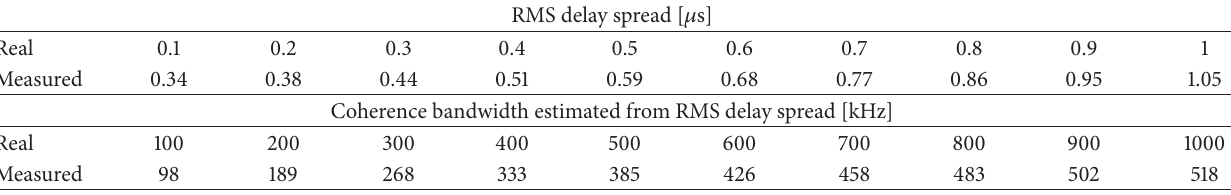
= 0.33 𝜇 s. waveform